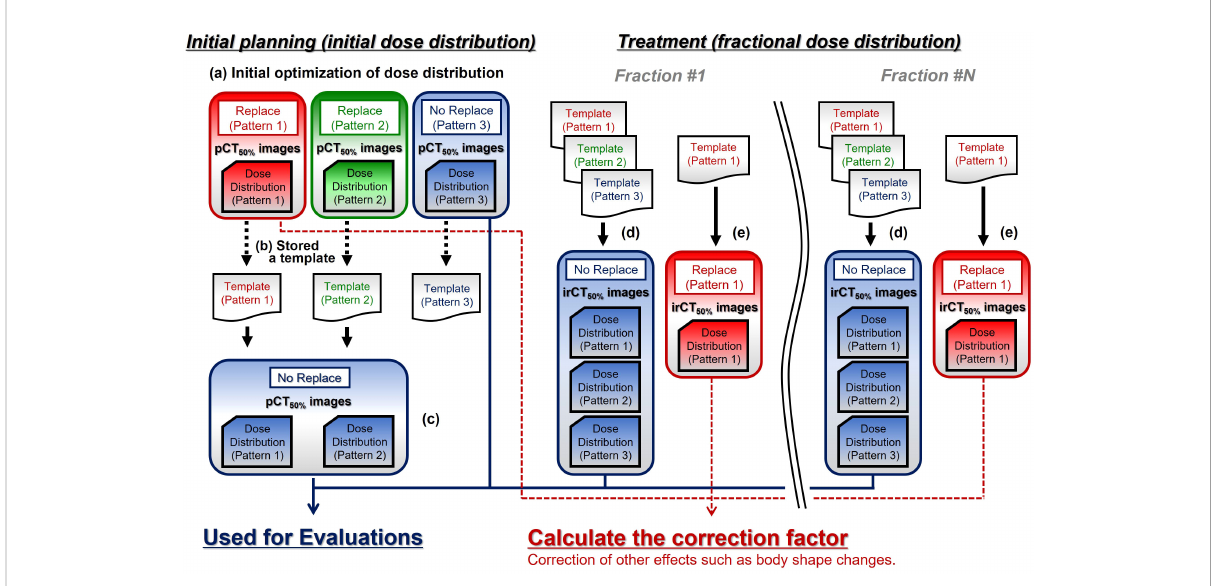
FIGURE 3 The calculation work fl ow of treatment planning computed tomography (CT) and fractional in-room CT (irCT) images. pCT 50% images, treatment planning CT images of the maximum exhalation phase; irCT 50% images, in-room CT images of the maximum exhalation phase; Replace, replace condition; No Replace, without replace condition; Template, irradiation conditions set (slice position, spot position in the plane of each slice position, and number of particles per spot